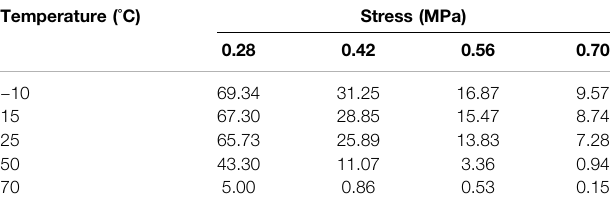
TABLE 4 | Shear fatigue life ( × 10 4 ) at different temperatures and stresses. Temperature ( ° C)